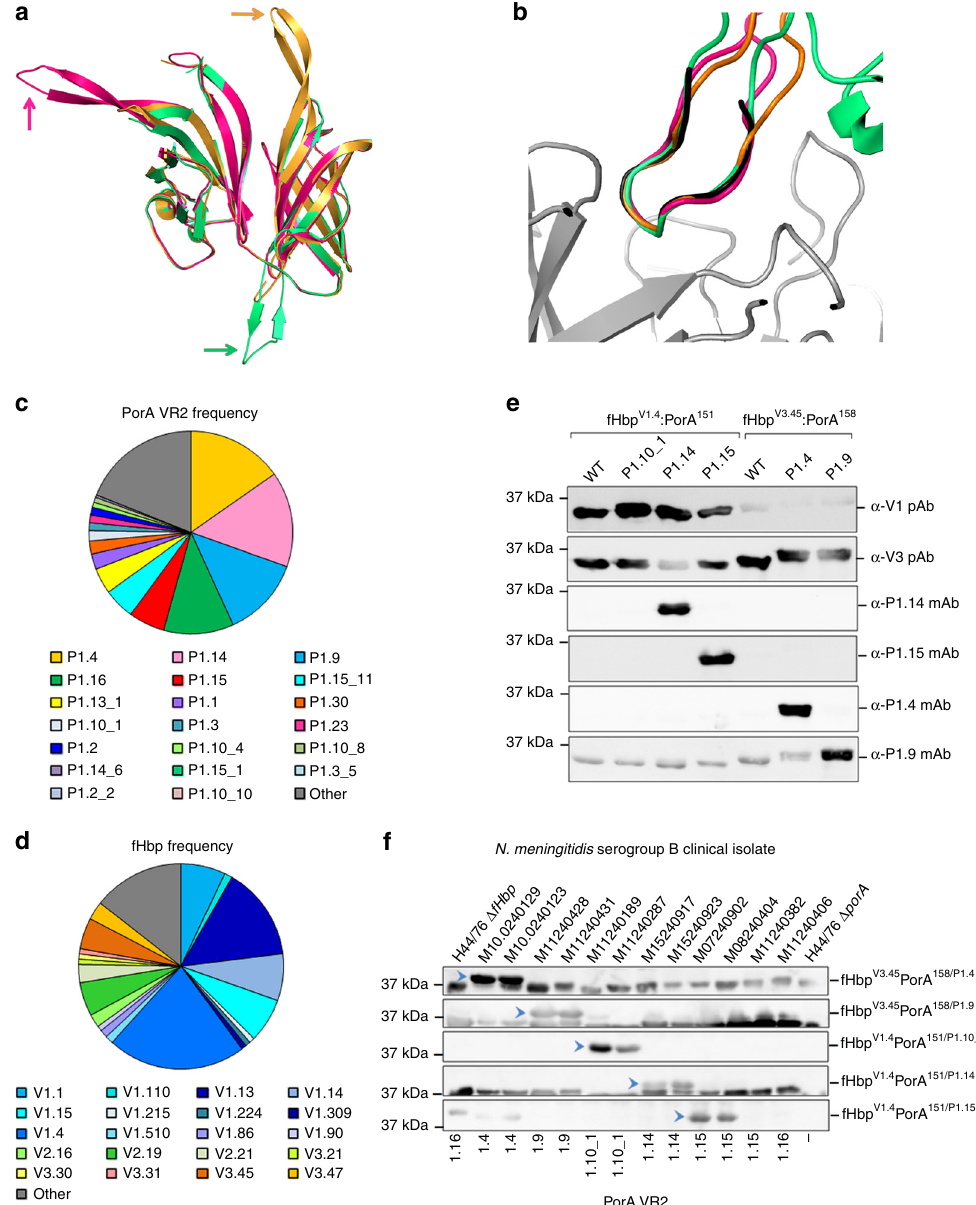
Fig. 4 Structure of ChAs and frequency of fHbp/PorA alleles in the UK. a Alignment of fHbp scaffolds from fHbp V1.4 :PorA 151/P1.16 (pink), fHbp V1.1 :PorA 294/ P1.16 (green) and fHbp V1.4 :PorA 309/P1.16 (orange), VR2 P1.16 is indicated for each ChA by the correspondingly coloured arrow. b Alignment of VR2 P1.16 region 'KDTNNNL' from fHbp V1.4 :PorA 151/P1.16 (pink), fHbp V1.1 :PorA 294/P1.16 (green) and fHbp V1.4 :PorA 309/P1.16 (orange) with the P1.16 peptide 'KDTNNNL' (black) in a complex with a bactericidal Fab fragment (grey) from mAb MN12H2 (PDB ID: 2MPA). Frequency of PorA VR2 ( c ) and fHbp peptides ( d ) in N. meningitidis serogroup B strains ( n = 243) isolated in 2016 in the UK. Data downloaded from the Meningococcal Research Foundation, 27 June 2017 (ref. 41 ). Other: remaining alleles that occur in <4 isolates. e Analysis of recombinant ChAs by SDS-PAGE and western blot. Immunoblots are probed with α -PorA VR2 mAbs: P1.4, P1.9, P1.14 and P1.15. f Detection of PorA (indicated by blue arrows) in a panel of N. meningitidis serogroup B isolates by mouse polyclonal antisera from ChAs fHbp V1.4 :PorA 151/P1.1.10_1 , fHbp V1.4 :PorA 151/P1.14 , fHbp V1.4 :PorA 151/P1.15 , fHbp V3.45 :PorA 158/P1.4 and fHbp V3.45 :PorA 158/P1.9 .